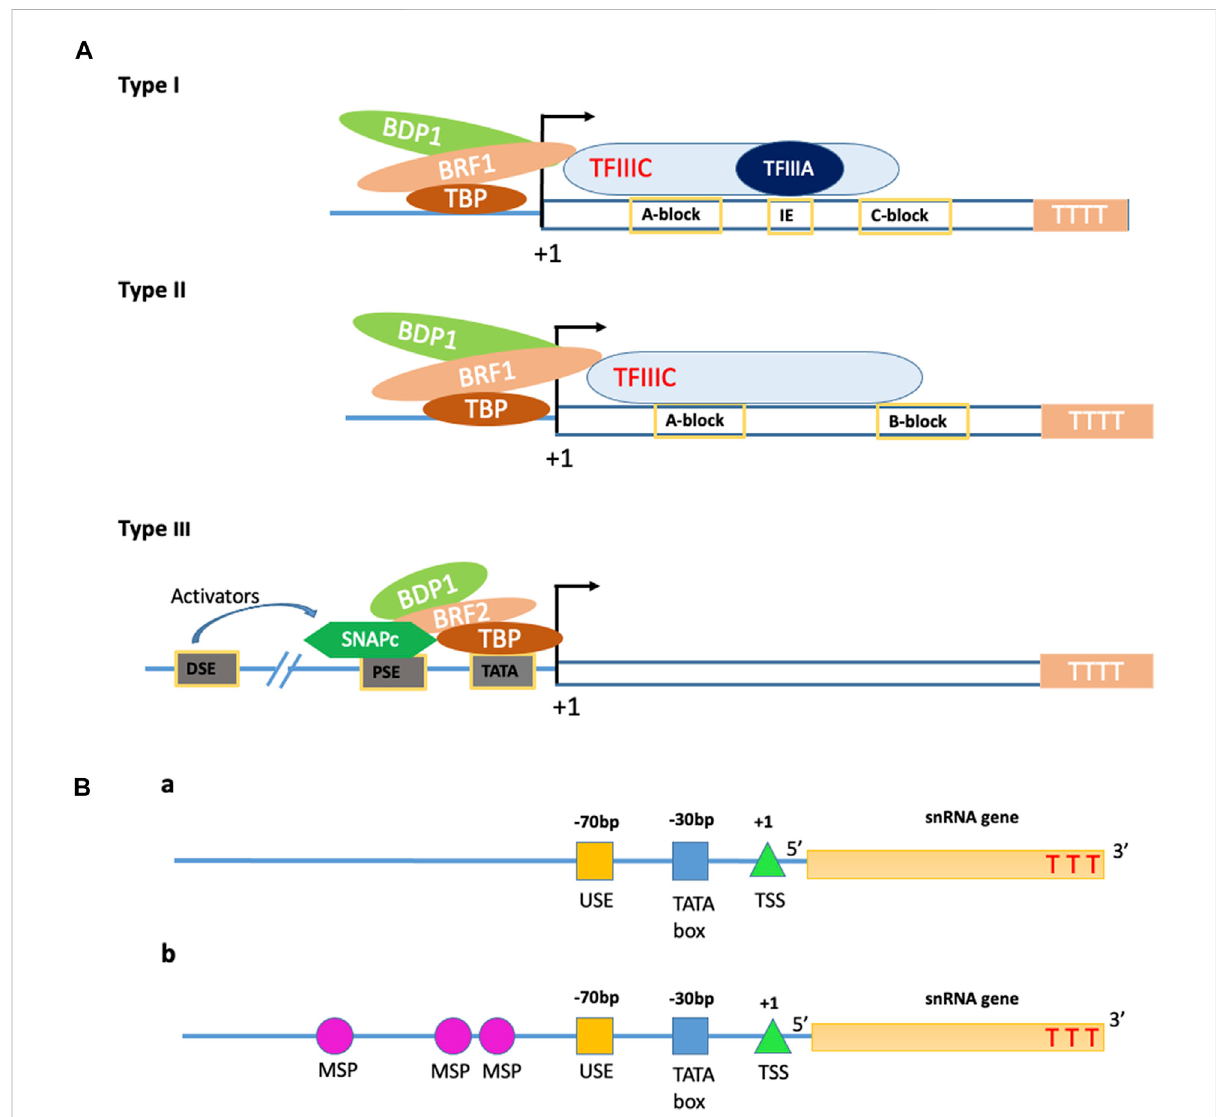
Structural properties of the Pol III promoters. (A) Schematic representation of the structure of different types of Pol III promoters. B-double prime 1 (BDP1), B-related factor 1 (BRF1), TATA-box binding protein (TBP), B-related factor 2 (BRF2), proximal sequence element (PSE), Distal sequence element (DSE), small nuclear RNA activating protein complex (SNAPc); +1 — Transcription start Site; TTTT — terminator site. (B) The structural arrangementsof plant Pol III promoters in adicot (a)and monocot (b) plants. The arrangementof regulatory elements, namely, TATA box,Upstream sequenceelement (USE),andTranscriptionstartsite(TSS)oftype3PolIIIpromotersindicotplants (a).Thesameregulatoryelements with the addition of monocot-speci fi c promoters (MSPs) in monocot Pol III promoters (b). TTT —